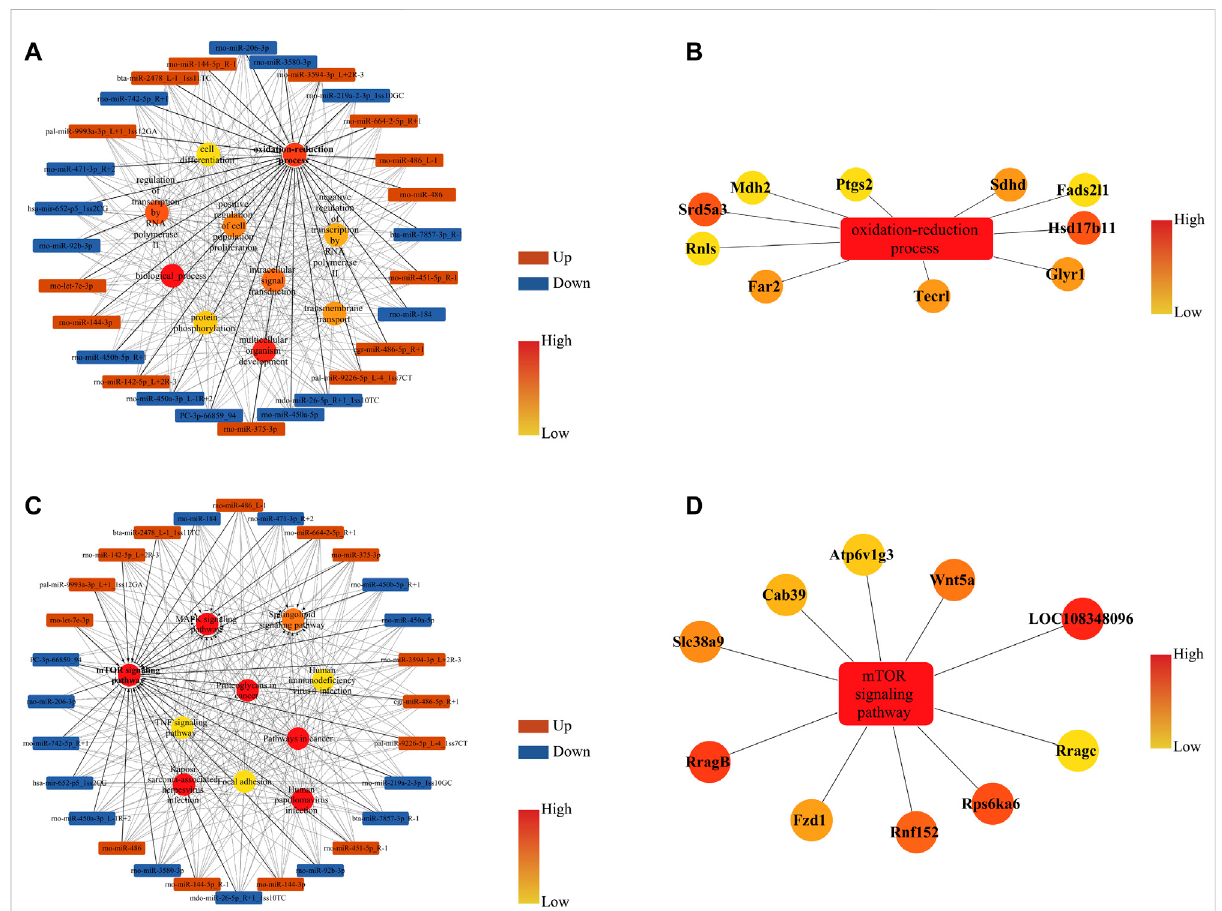
miRNA-GO and miRNA-KEGG networks of DE miRNAs and their corresponding target genes (mRNAs) in rat ovaries after acupuncture intervention compared with DOR rats. (A) Box nodes denote the DE miRNAs, circle nodes denote the fi rst 10 degree BPs, and edges show the interactionsbetweenmiRNAsandGOs. (B) Extractedfrom A ,boxnodesindicateBP,circlenodesindicatethe fi rst10targetgenes,andedgesindicate the interactions between genes and GO terms. (C) Box nodes denote the DE miRNAs, circle nodes denote the fi rst 10 degree KEGG, and edges showtheinteractionsbetweenmiRNAsandpathways. (D) Extractedfrom C ,boxnodesrepresentpathways,circlenodesrepresentthe fi rst10target genes, and edges show the interactions between genes and pathways. ACU, acupuncture group; BP, biological process; CON, control group; DOR, diminished ovarian reserve; DE miRNAs, differentially expressed miRNAs; GO, Gene Ontology; KEGG, Kyoto Encyclopedia of Genes and